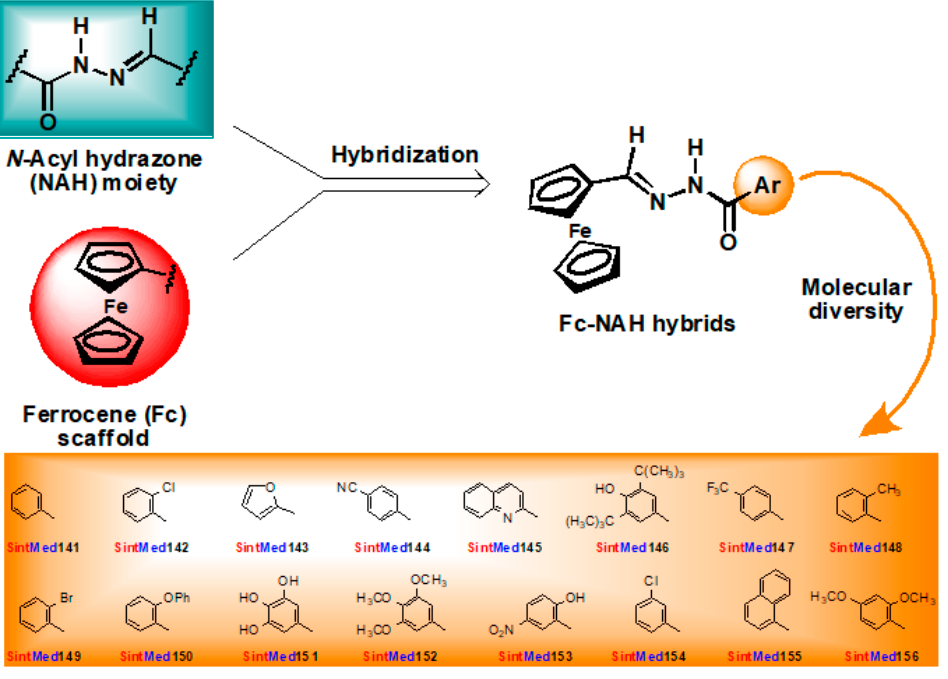
Figure 1. Molecular hybridization strategy applied to the design of ferrocene- N -acyl hydrazones (Fc-NAH).